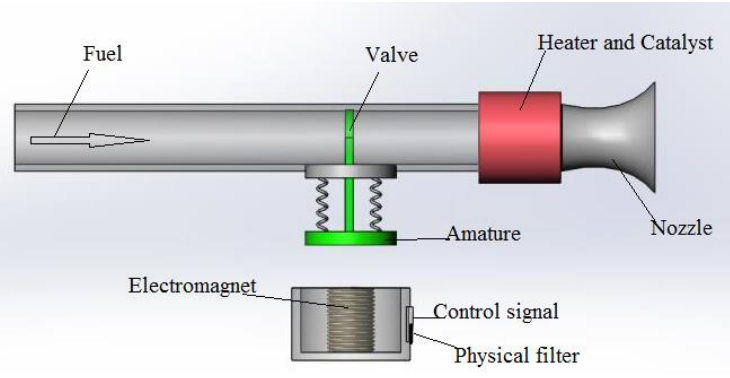
Figure 1. Structural diagram of the thruster.